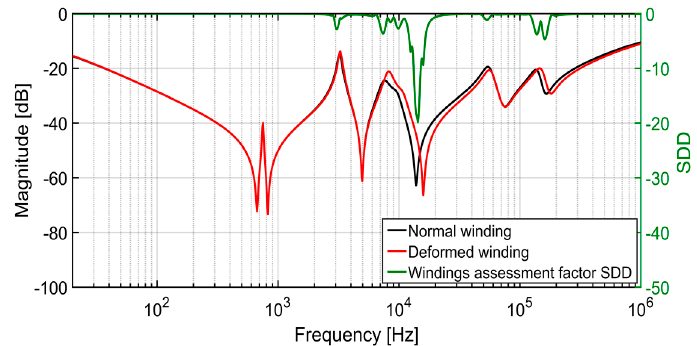
Figure 12. Representation of the proposed method for identification of the degree of deviation between two TFs of a three-phase